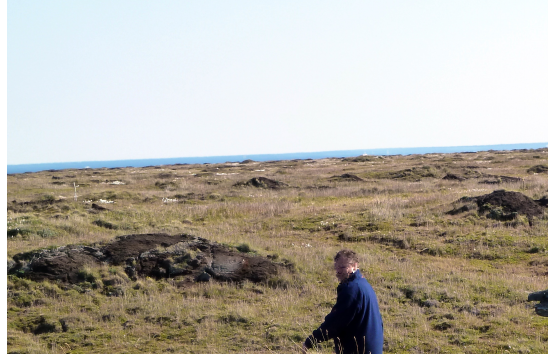
Figure 22. Photograph of peat mounds (incipient baydzharakhs) in the northern part of Muostakh, where the island’s surface is affected by strong permafrost thaw subsidence (person for